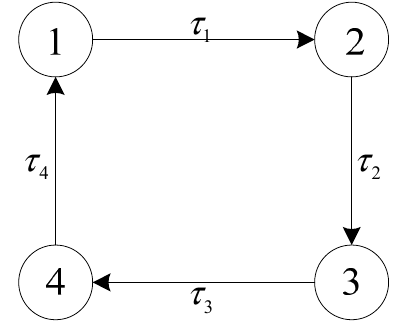
Figure 4. Experiment 2 system communication topology.